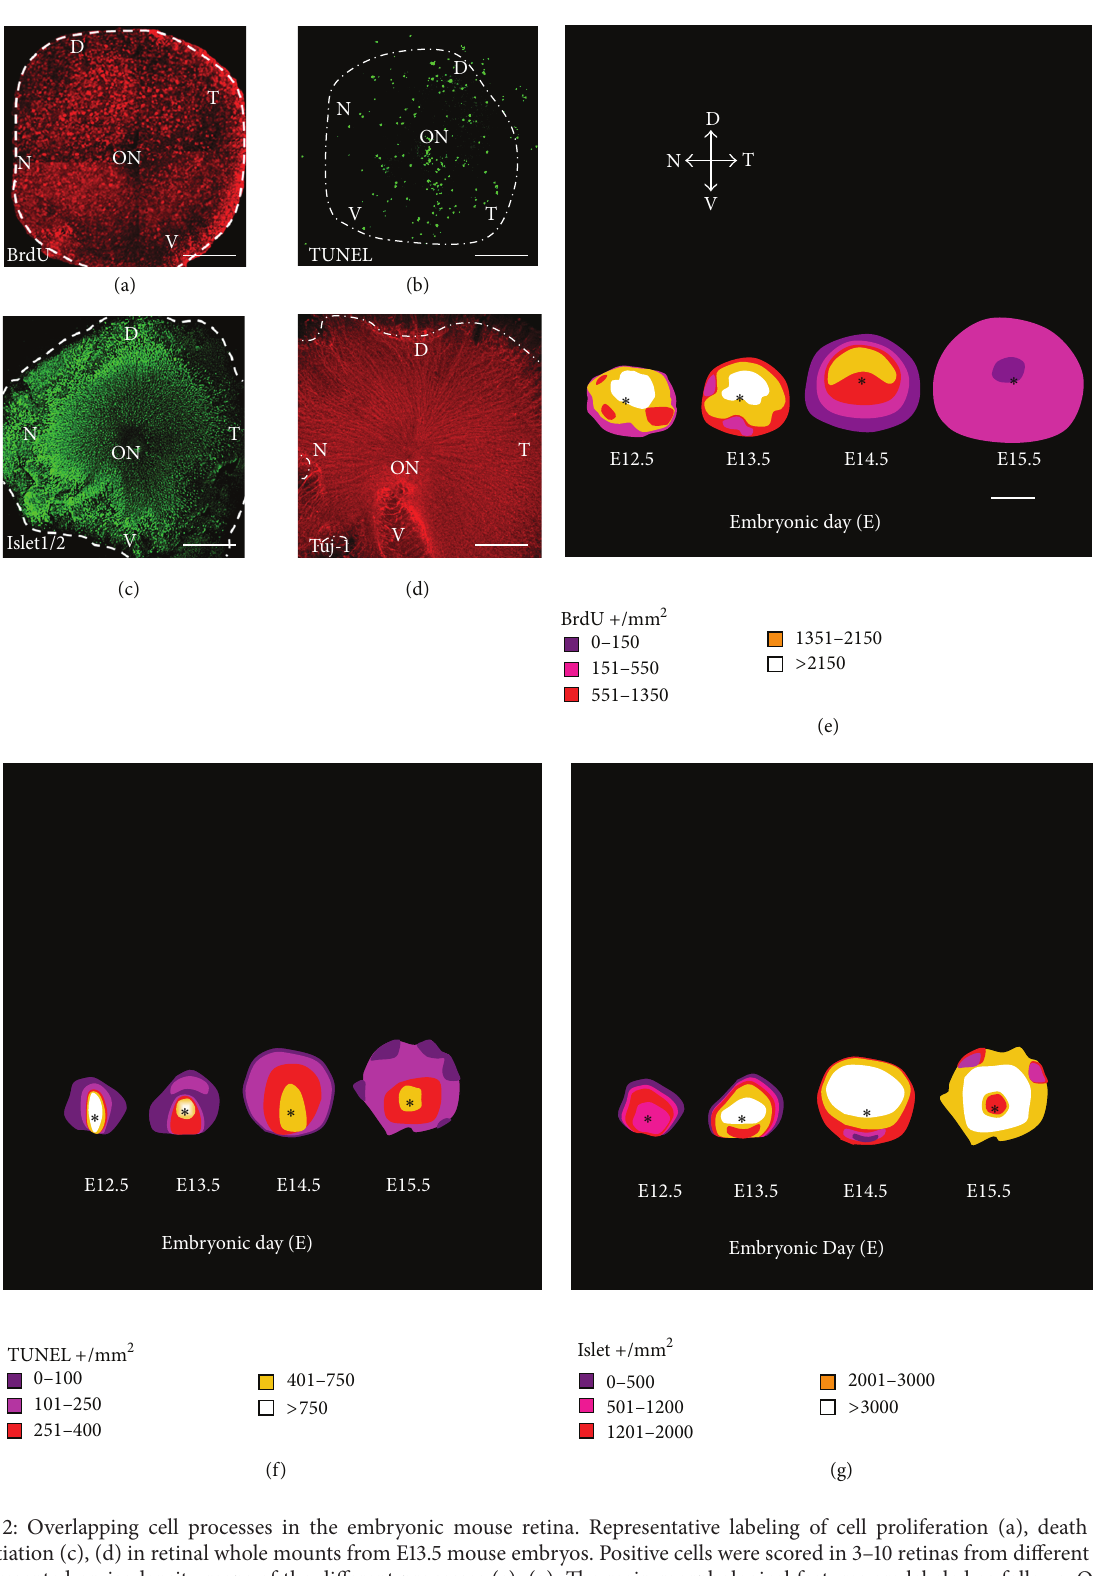
Figure 2: Overlapping cell processes in the embryonic mouse retina. Representative labeling of cell proliferation (a), death (b), and differentiation (c), (d) in retinal whole mounts from E13.5 mouse embryos. Positive cells were scored in 3–10 retinas from different embryos and represented on isodensity maps of the different processes (e)–(g). The main morphological features are labeled as follows: ON and ∗ : optic nerve; D: dorsal; V: ventral; T: temporal; N: nasal. Scale bars represent 150 𝜇 m (a)–(d) and 300 𝜇 m